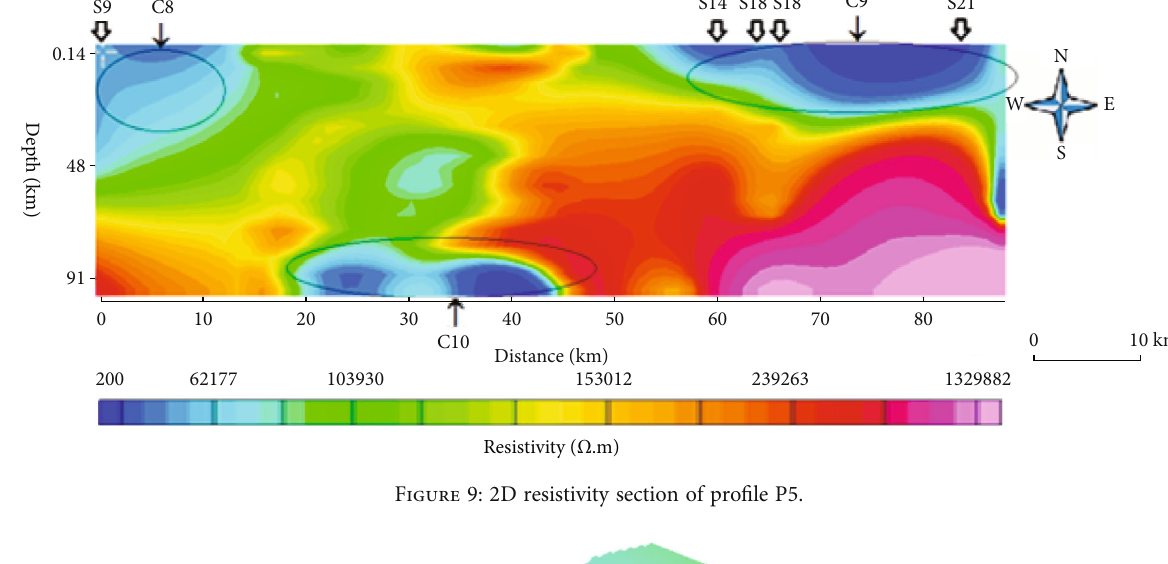
Figure 9: 2D resistivity section of pro fi le P5.